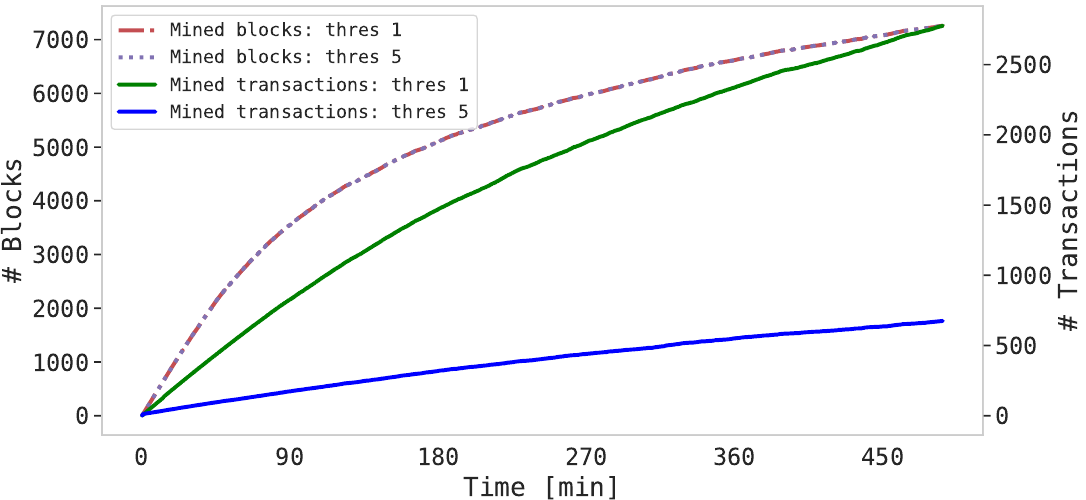
Figure 6. Mined blocks and transactions of the SIEMs enabled as miners with different